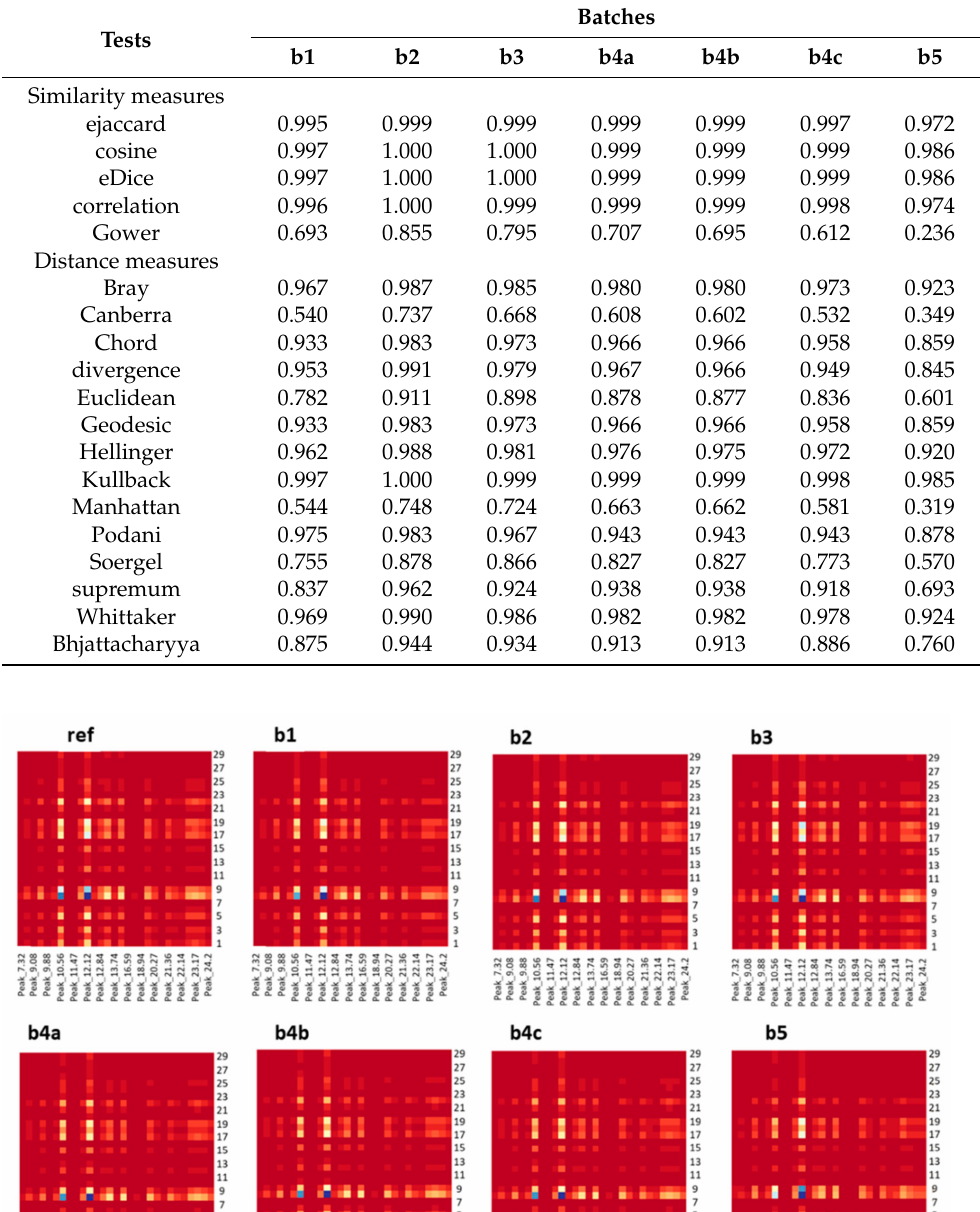
Table 5. Results of the similarity and distance measures that were performed employing the “proxy” package in RStudio. The CMS peak ratios of the tested batches b1, b2, b3, b4 (a, b, c) were compared with those of the reference batch.